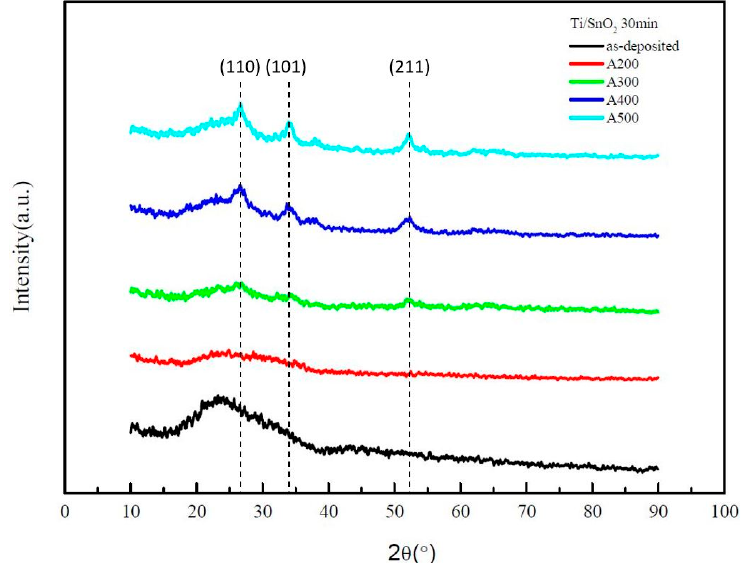
Figure 1. X-ray diffraction (XRD) patterns of as-deposited and annealed Ti:SnO 2 films. Figure 1. X-ray di ff raction (XRD) patterns of as-deposited and annealed Ti:SnO